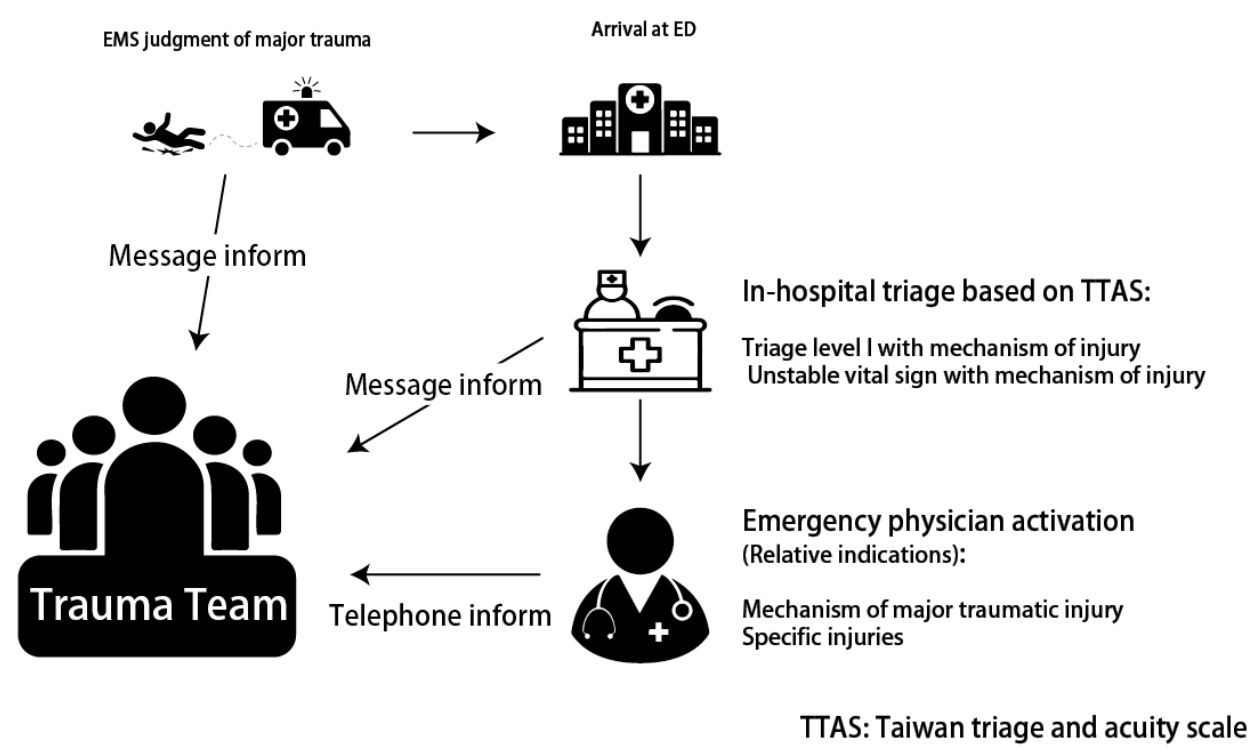
Figure 1. Flow chart of trauma team activation.